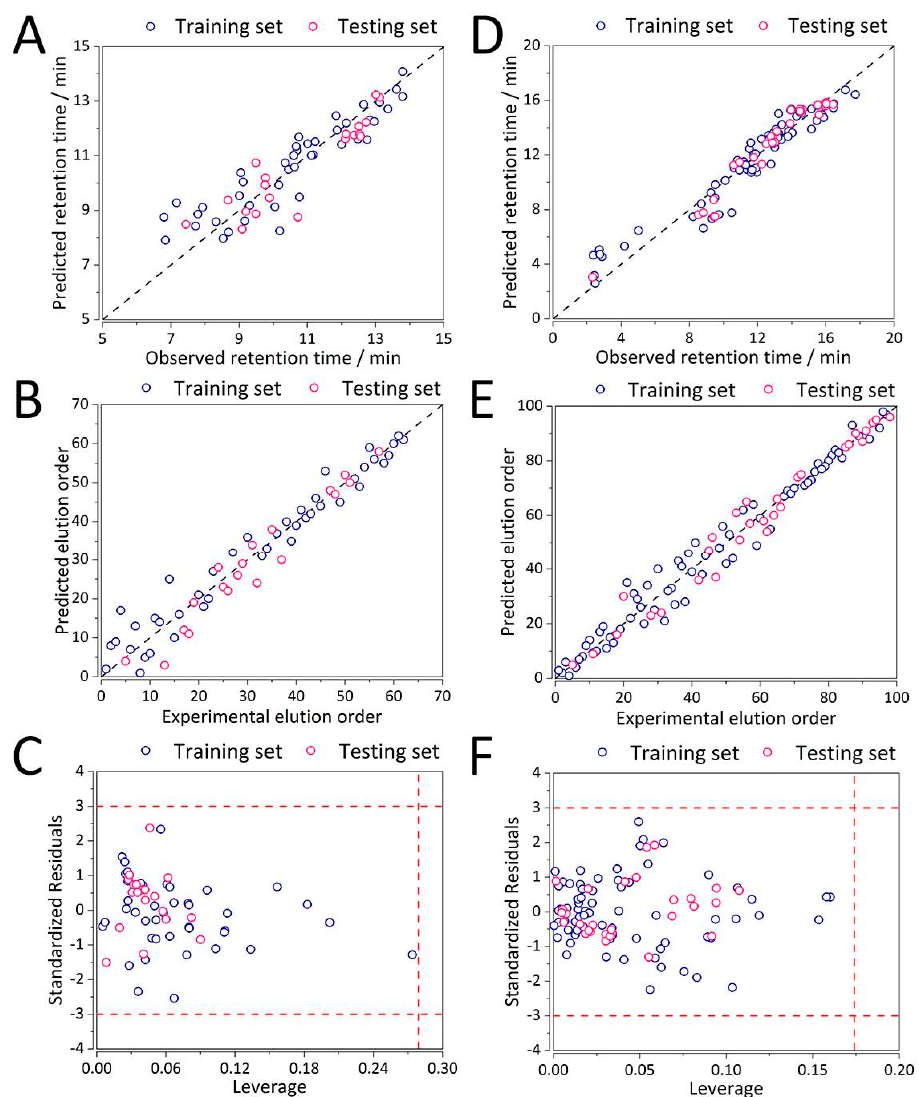
Figure 5. Performance of the MLR-NLP method for prediction of ( A ) retention time, ( B ) elution order, and ( C ) applicability domain for case study 1 (separation of organic molecules using Supelcosil LC, t G = 10 min, T = 35 °C), ( D ) prediction of retention time, ( E ) elution order, and ( F ) applicability domain for case study 2 (separation of synthetic peptides on Xterra, t G = 20 min, T = 40 °C). Abbreviations: t G —gradient retention time, T —temperature.